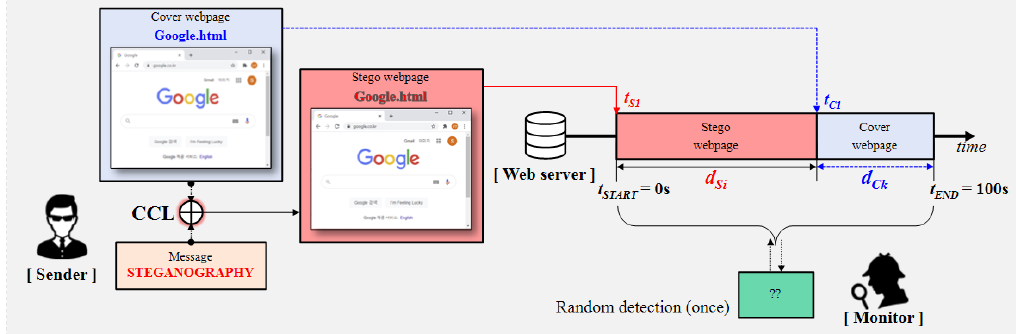
Figure 15. An experiment to measure M U in the real web environment.